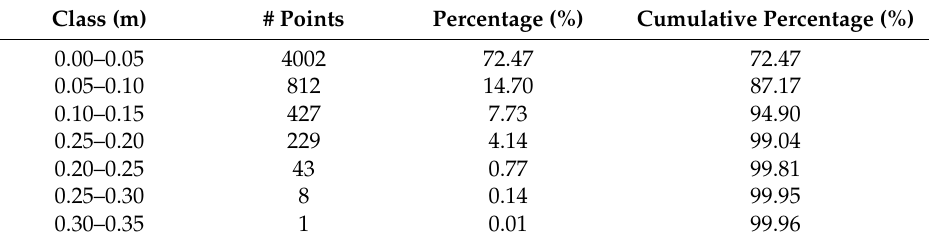
Table 4. Number of points in different layers of overlap